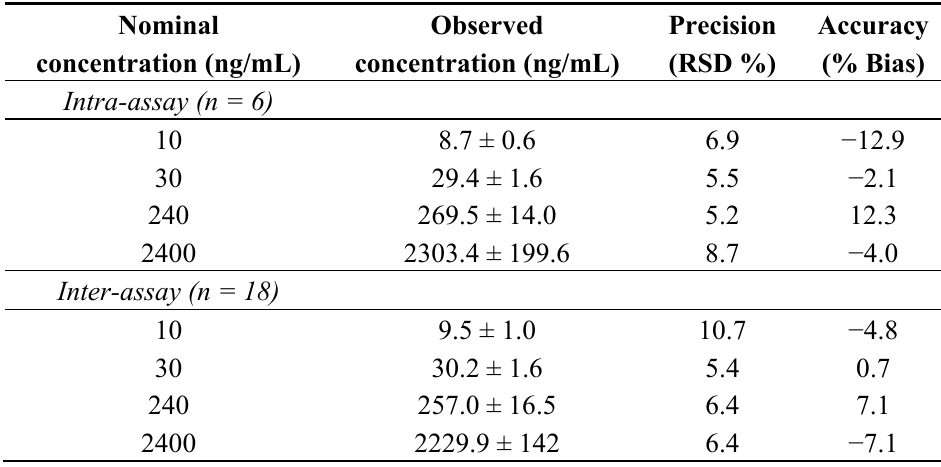
Table 1. Intra-day and Inter-day Precision and Accuracy of BMEDA in K Dog Plasma.